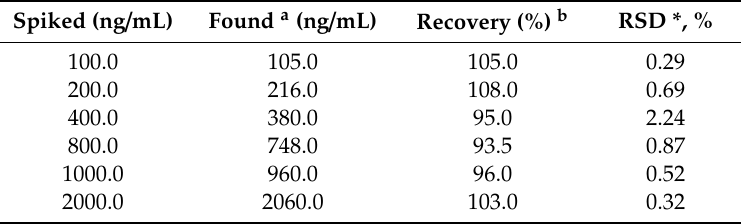
Table 2. Extraction of clonidine from mice plasma using the proposed HPLC method. Spiked (ng / mL) Found a (ng / mL) Recovery (%) b